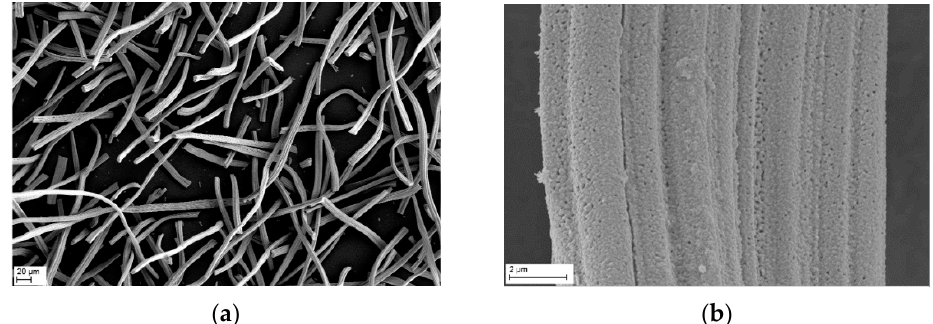
Figure 2. SEM micrographs of YSZ felt before thermal treatment in different magnification ( a , b ). After thermal treatment at a high temperature of 1923 K the grains grew up to 2 µm–8 µm whereas the diameter of the fiber remained or shrank (Figure 3a).